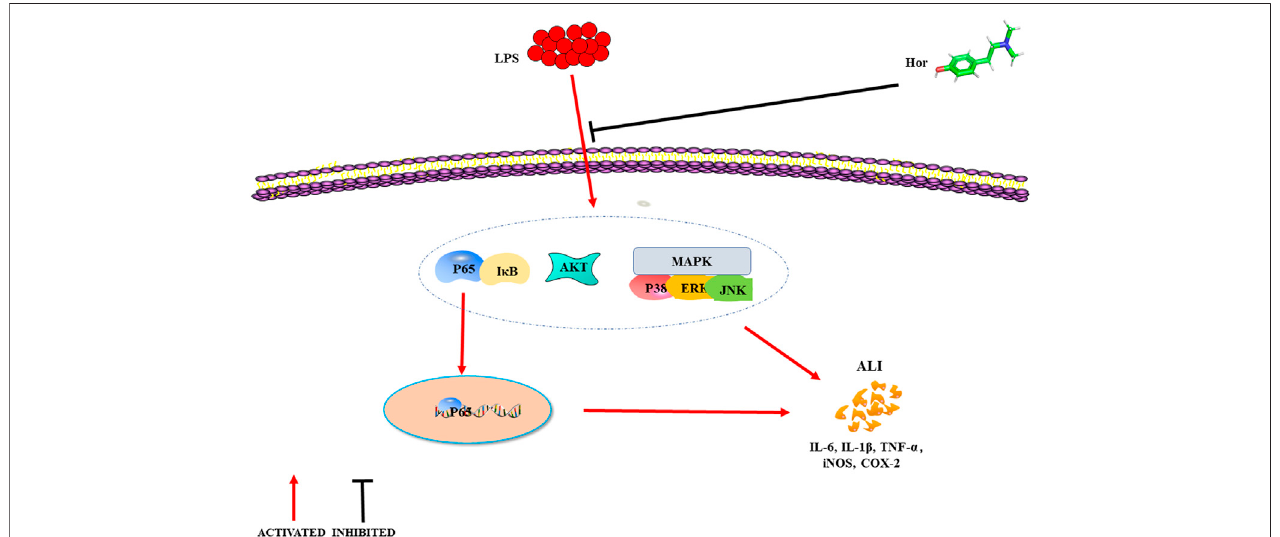
FIGURE 9 | Mechanism of hordenine alleviating LPS-induced ALI. LPS successfully induces ALI in mice, and lung tissue injury was evident when the levels of in fl ammatory mediators increased. Hordenine alleviated LPS-induced ALI, inhibited the expression and secretion of in fl ammatory mediators, and relieved pulmonary tissue edema. The potential mechanism by which hordenine alleviates lung injury may be inhibition of AKT, NF- κ B, and MAPK signaling activation. ALI: acute lung injury; LPS: lipopolysaccharide; AKT: protein kinase B; I κ B: inhibitor of nuclear factor- κ B; MAPK: mitogen activated protein kinase; ERK: extracellular signal-regulated kinase; JNK: c-Jun N-terminal kinase; IL-6: interleukin-6; TNF- α : tumor necrosis factor- α ; iNOS: inducible nitric oxide synthase; COX-2: